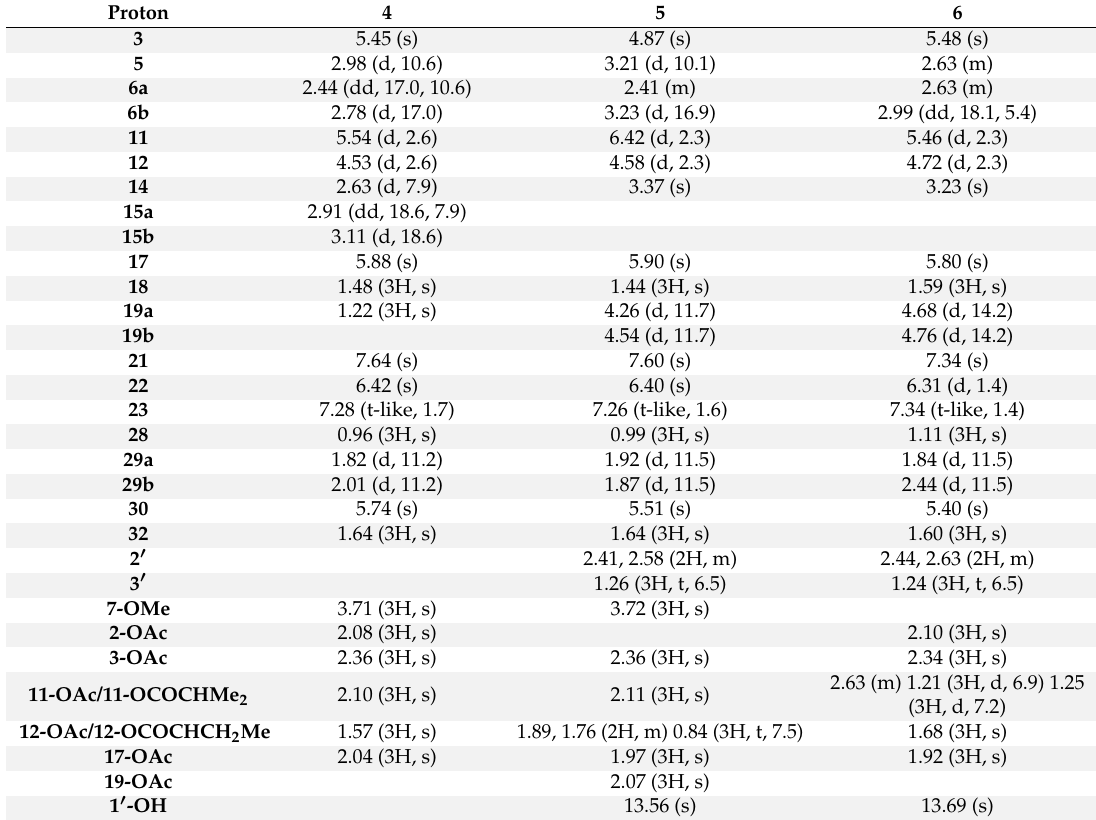
Table 3. 1 H-NMR (500 MHz) data of compounds 4 – 6 (CDCl 3 , δ H in ppm, J in